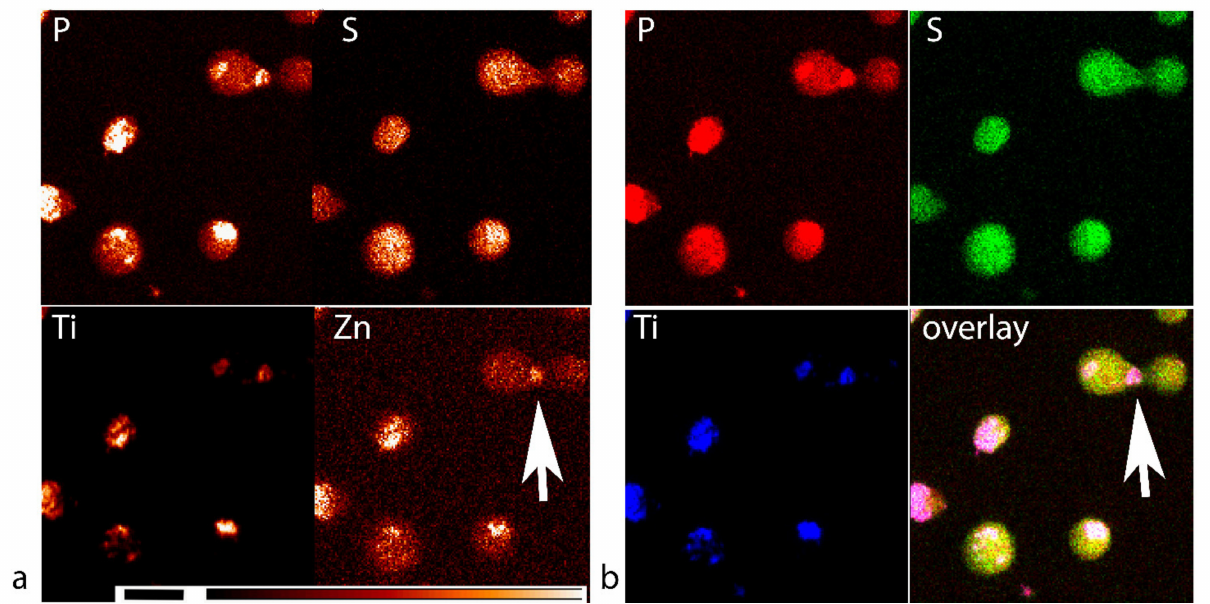
Figure 4. XFM image of HeLa cells treated with nanocomposites for 24 h and incubated post-treatment for 24 h. These cells come from the same batch that was used for flow cytometry shown in Figure 2. ( a ) Red color temperature elemental signal schema with size bar of 20 microns and color bar indicating signal intensity changes from absent–black, to high–white. ( b ) Overlay image for P (red), S (green), and Ti (blue) represent the following: nucleic acids–highest P content, cellular proteins–highest S content, and nanoconjugates–Ti content. Due to the absence of Ti in biological samples, XFM signal-to- background ratio for this element is the strongest. The overlay image shows that distribution patterns of nanoconjugates in the cells vary significantly. The white arrow points to what looks to be a cytokinetic bridge during the telophase, with an increased Zn concentration (red temperature image ( a )) and overlay of Ti, P, and S signals (three colors overlay image ( b